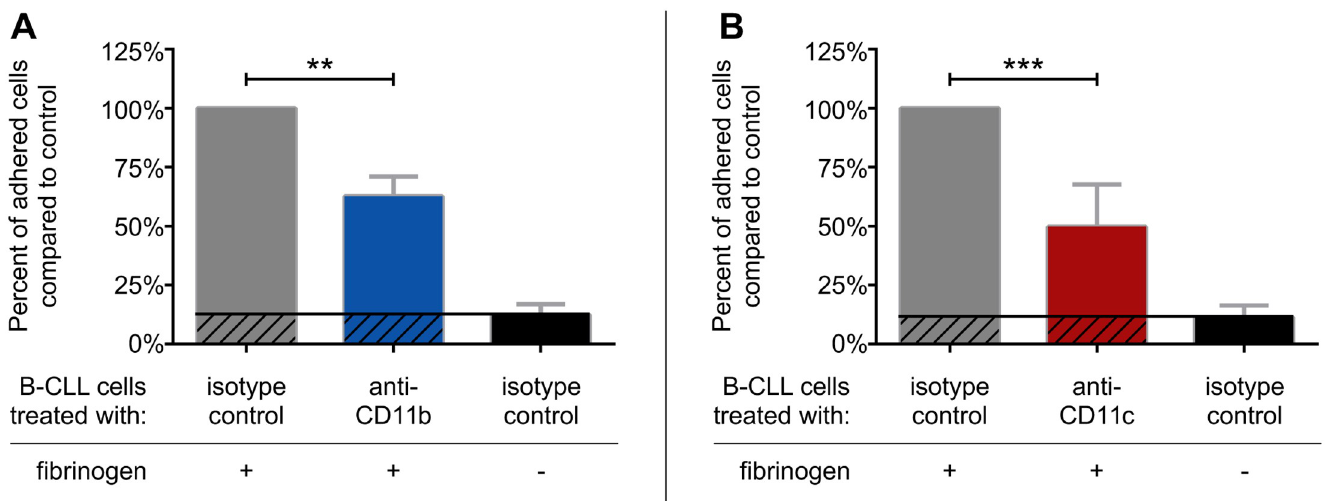
Fig 3. The effect of CD11b and CD11c specific antibodies on the adhesion of CLL B cells to fibrinogen coated and PLL-PEG blocked surface. The assay was carried out on CLL B cells on the 3 rd day of culture employing fibrinogen coated surfaces blocked by PLL-PEG or, as negative control, surfaces without fibrinogen Adherence was performed in the presence of (A) CD11b- or (B) CD11c- specific antibodies. (A) For CD11b results of four patients (Patient 3, 4, 5, 7), (B) for CD11c results of eight patients are summarized as mean +/- SD, normalized to control presented as 100%. One-way ANOVA with Tukey’s post-test was used to determine significant differences compared to control, � = p < 0.05; �� = p < 0.01; ��� = p < 0.001.